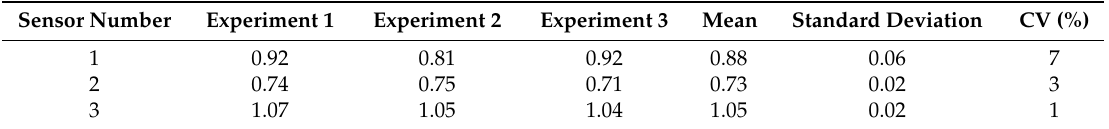
Table 1. Slopes (mV/ µ g/m 3 ) for the three sensors used in the three experiments with the mean, standard deviation, and the percent coefficient of variation (CV) for each